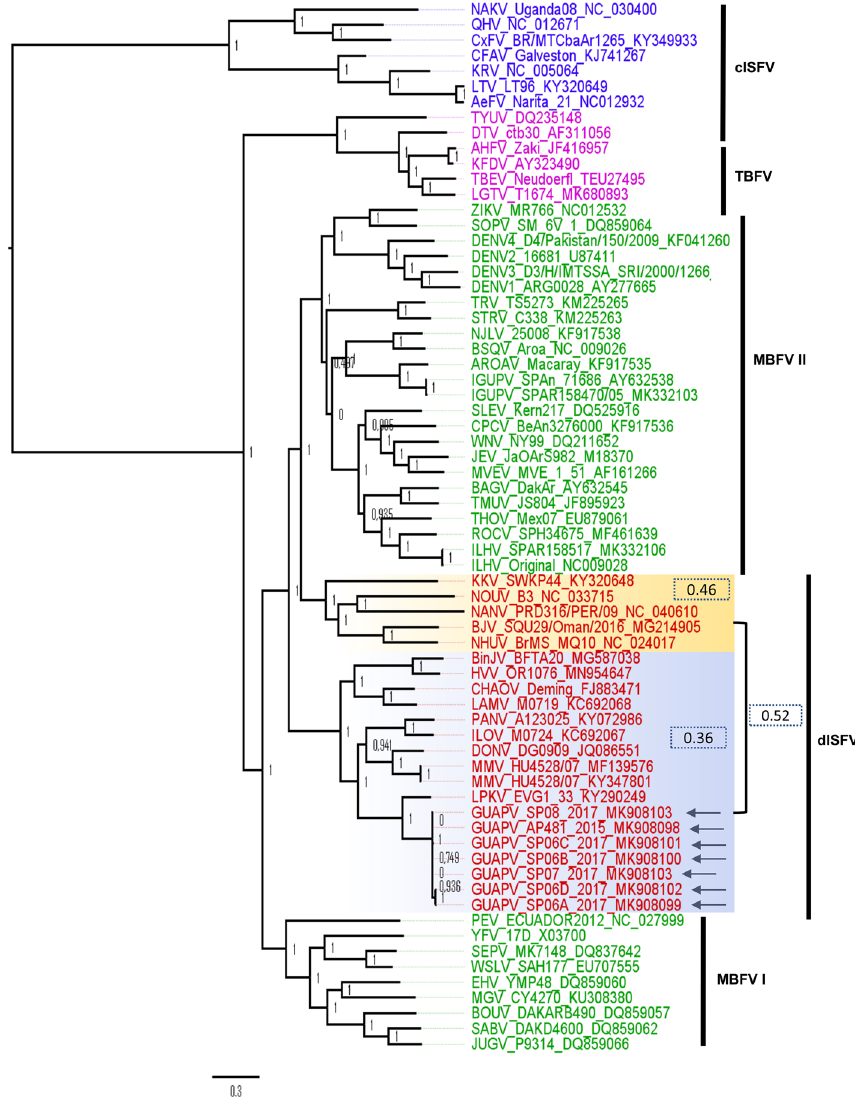
Figure 4. Maximum likelihood phylogeny of the genus Flavivirus members. Strain names and GenBank accession numbers are given after the names of the viruses. The GUAPV sequences of this study are represented by arrows. The genetic distance based on p-distance was computed within and between dISFs clades. Highlighted in blue are classical insect-specific flaviviruses (cISFs), in pink are tick-borne flavivirus (TBFV), in green are mosquito-borne flavivirus (MBFV) and red are dual host-related insect-specific flavivirus (dISFV). The tree is rooted at the midpoint and approximate Likelihood-Ratio values are indicated in the nodes of the